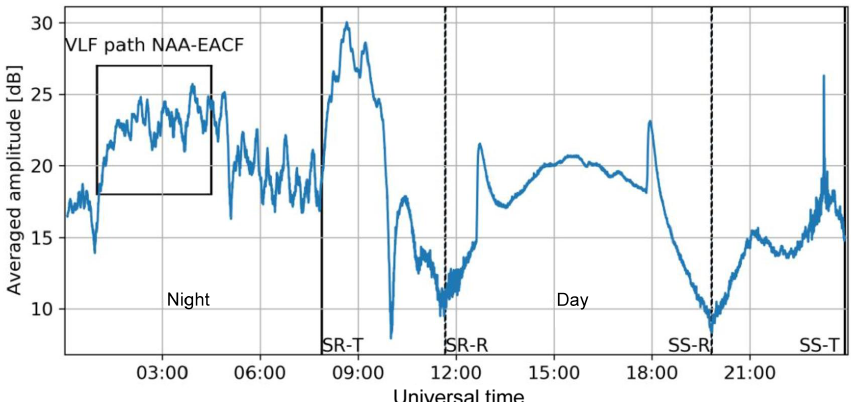
Figure 3. VLF amplitude from NAA transmitter station detected with 15s time resolution at EACF on 10 July 2007. The vertical lines mark the sunrise (SR) and sunset (SS) at NAA transmitter station ( T , full lines) and at receiver station ( R , dashed lines). The periods of completely night and day in the NAA–EACF VLF path are identified. The box marks the time interval of data used to perform the spectral